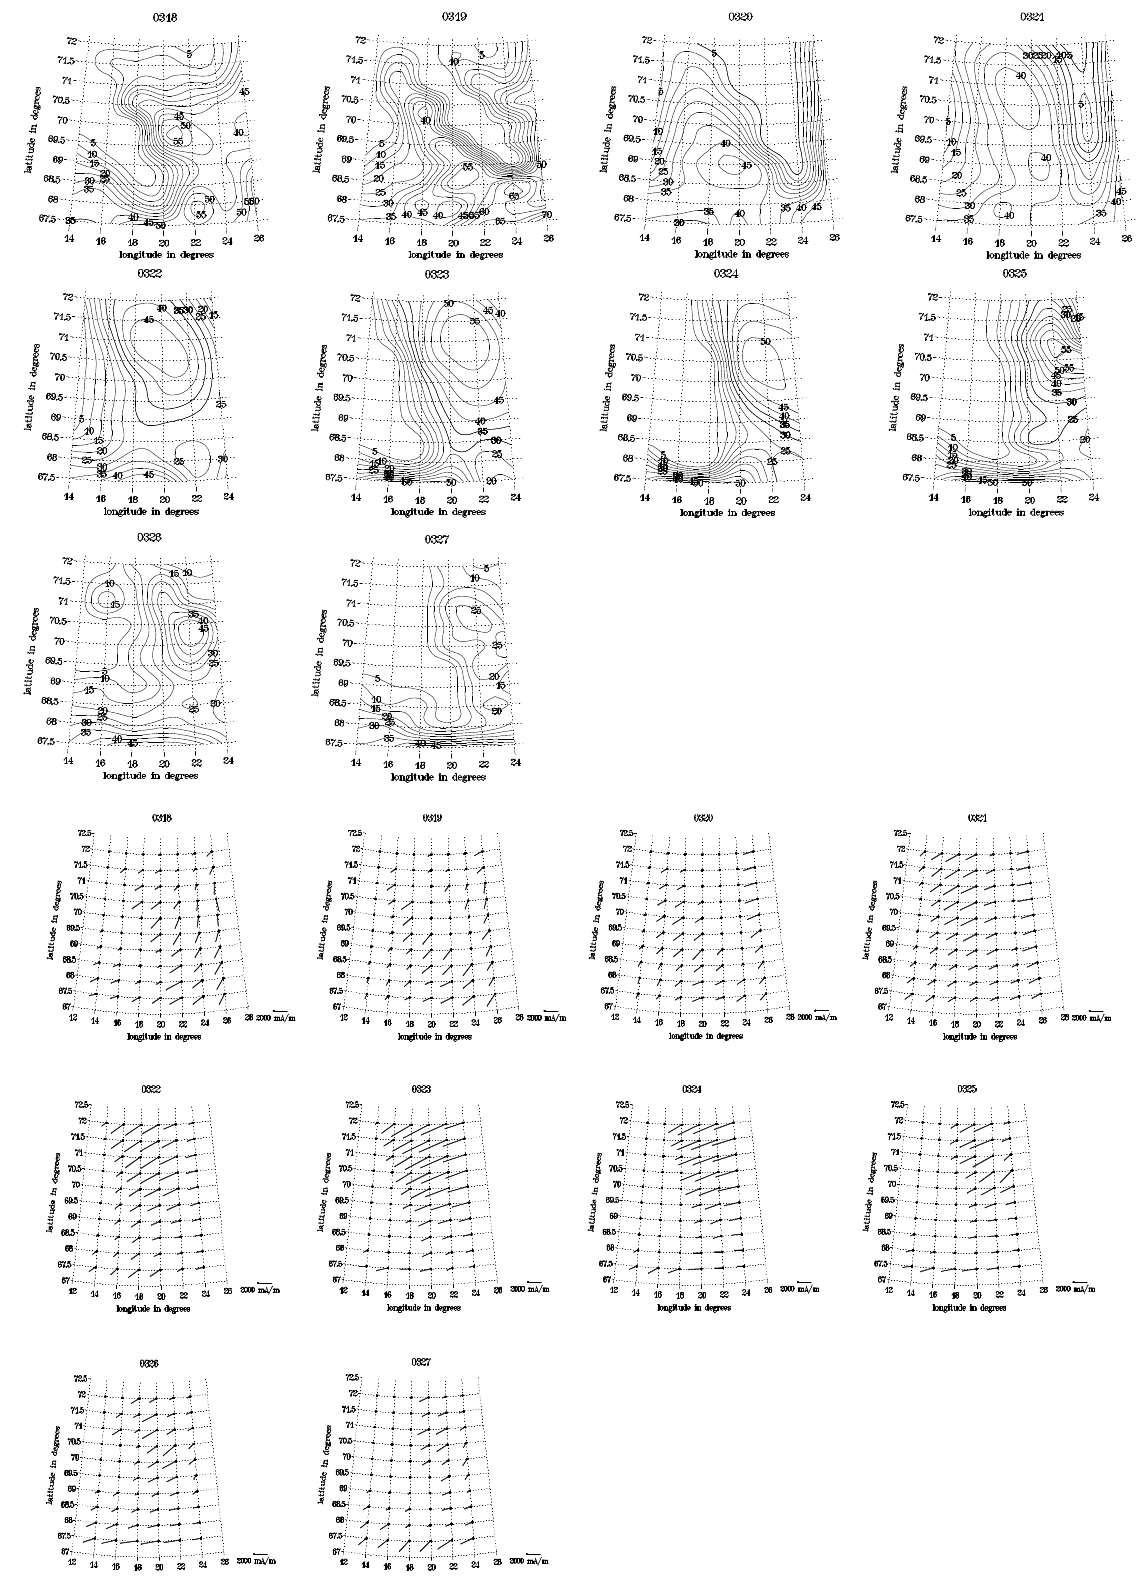
Fig. 6. Analysis results of the method of characteristics (panels a – c ) and the AMIE method (panel d ). (a) Hall conductance 6 H ; (b) True ionospheric currents J ; (c) field-aligned currents j || (crosses denote downward, squares upward currents; dots give the positions of isolated conductance maxima above 69 ◦ of latitude, cf. panel a); (d) Global Hall conductance distribution in the morning